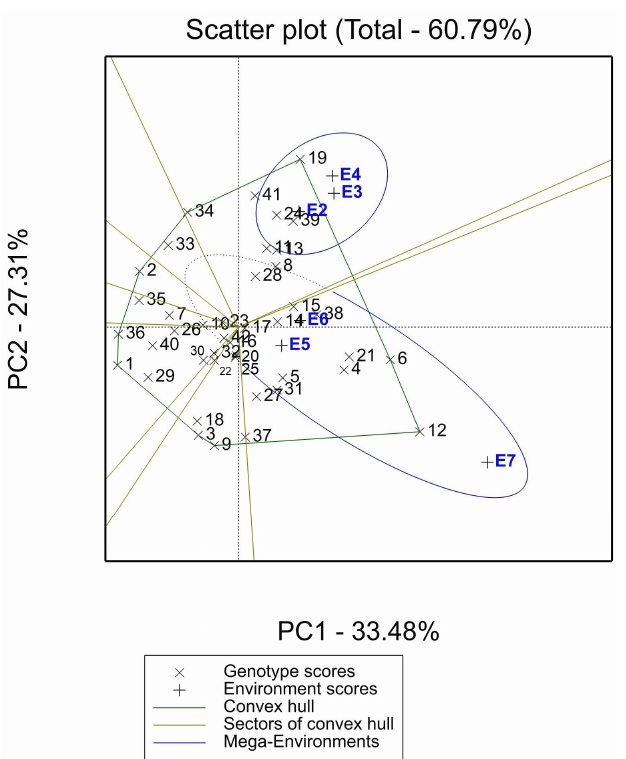
Figure 2. GGE biplot of tested accessions in validation trials for yield data (SY) explained 60.40% of the total variability. E2: Marchouch-2016/17-imazethapyr at 75 g a.i. ha -1 , E3: Marchouch-2016/17-metribuzin at 210 g a.i. ha -1 , E4: Marchouch-2016/17-no herbicide treatment, E5: Terbol-2018/19-imazethapyr at 75 g a.i. ha -1 , E6: Terbol-2018/19-metribuzin at 210 g a.i. ha -1 and E7: Terbol-2018/19-no herbicide treatment. Accessions numbered 1 to 42 are listed in Table 5.